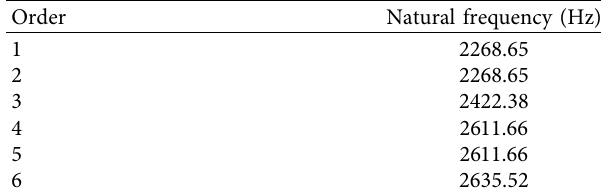
Table 2: Gear modal analysis